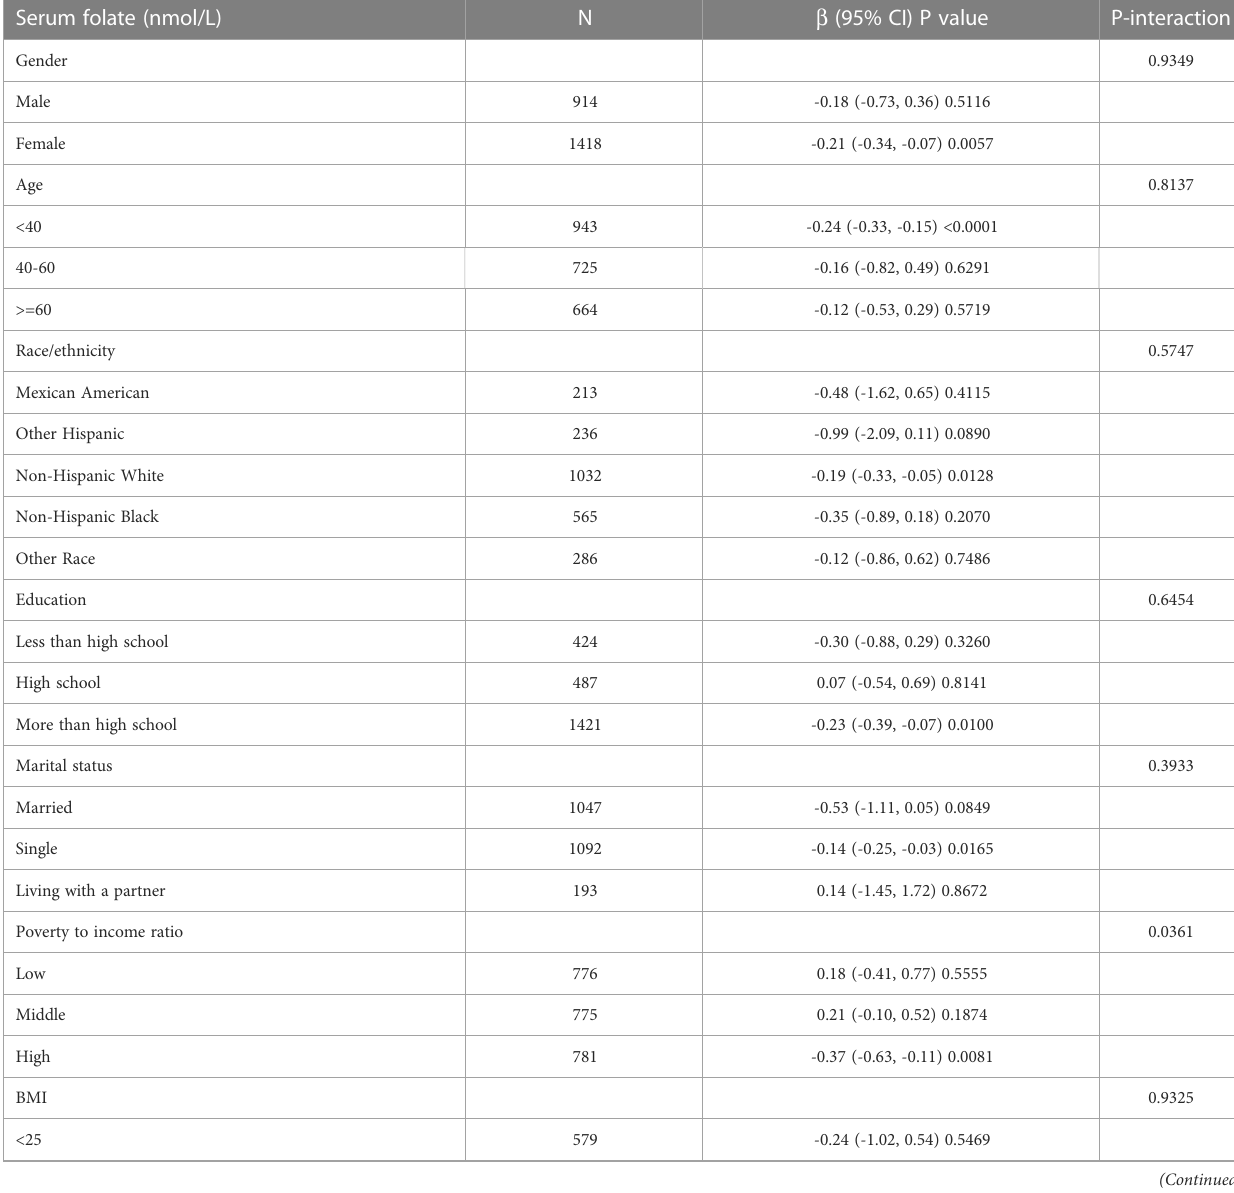
TABLE 3 Strati fi ed associations of association between the serum folate and blood eosinophils counts. Serum folate (nmol/L) N b (95% CI) P